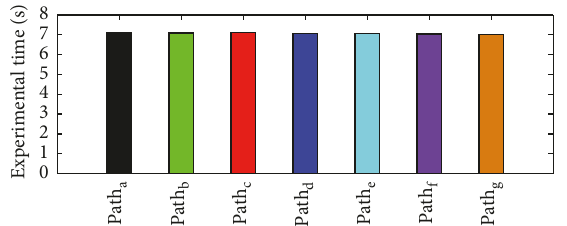
Figure 5: The experimental time in different relative position cases. We define the experimental time as the time when the two pedestrians have both reached the destination.